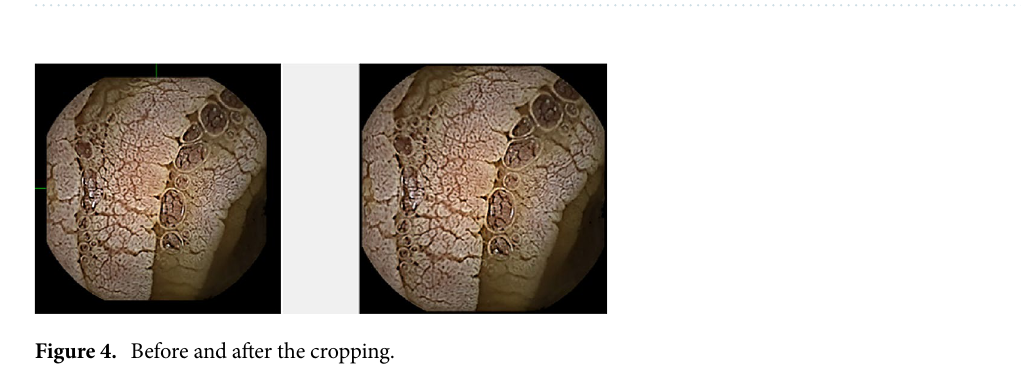
Figure 3. Steps required to remove the unwanted information. (1) Black and White image, (2) binary image, (3) centre of the regions, (4) final result.